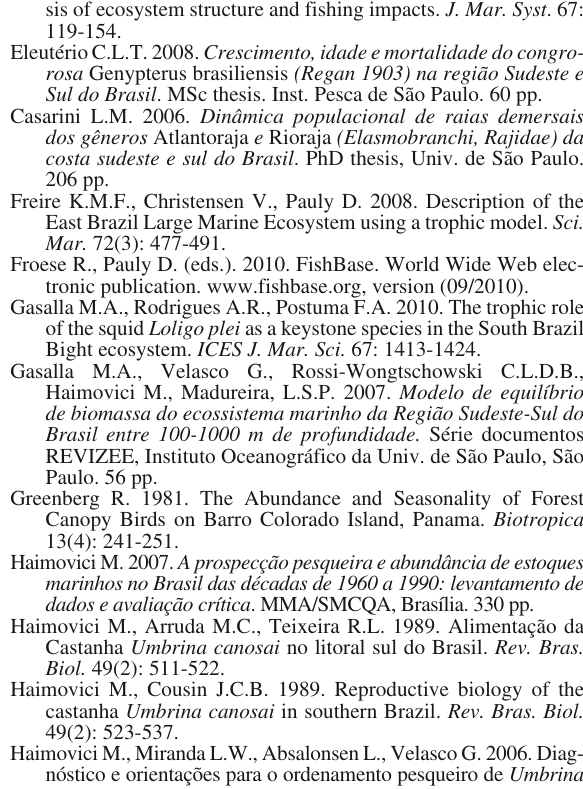
Brasil: Dinâmica Populacional das Espécies em Explotação . Série documentos REVIZEE, Instituto Oceanográfico da Univ. de São Paulo, pp. 139-144. Angelescu V., Prenski L.B. 1987. Ecologia trófica de la merluza común (Merluccidae, Merluccius hubbsi ). Parte 2. Dinámica de la alimentación analizada sobre la base de las condiciones am- bientales, la estructura y las evaluaciones de los efectivos en su área de distribución. Contr. INIDEP, Mar del Plata. 561: 1-205. tential impacts of trawling in a marine ecosystem of the south- east coast of India. Ecol. Model. 221: 2604-2614.